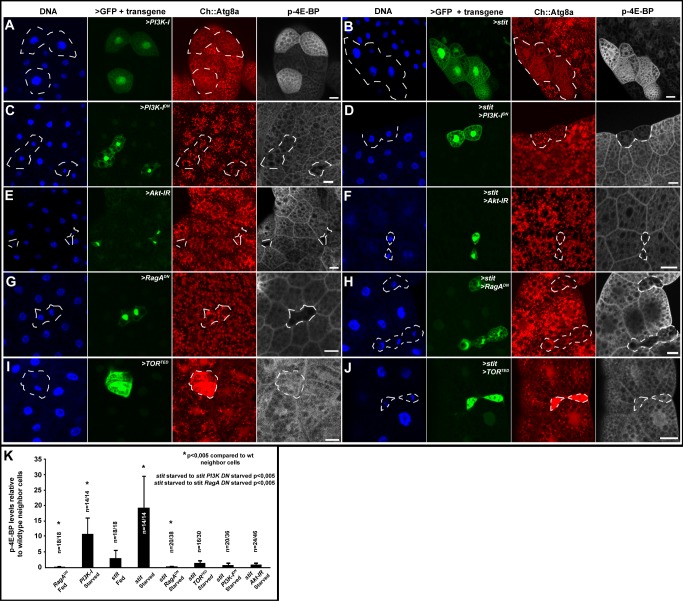
The PI3K-I/TORC1signalling cassette is required for Stit-dependent protection against starvation.Clonal expression (cells marked by GFP/hatched line) of stit and/or transgenes interfering with TORC1 signaling components in the fat body of starved (5 h) larvae expressing Ch::Atg8a under the control of a fat body promoter (A) PI3K-I-expressing cells have larger nuclei, are protected from starvation-induced Ch::Atg8a puncta formation, and maintain high p-4E-BP levels compared to wild-type neighbors. (B) stit-expressing cells behave like PI3K-I-expressing cells in (A). (C) PI3K-IDN-expressing cells are smaller and show Ch::Atg8a autophagic puncta and low levels of p-4E-BP (indistinguishable from neighbor cells). (D) stit and PI3K-IDN co-expression resulted in smaller cells with autophagic puncta and low levels of p-4E-BP following starvation, indicating PI3K-I signaling lies downstream of Stit. (E) Akt-IR, (G) RagADN, and (I) TORTED-expressing cells are smaller, readily form autophagic puncta, and had lower or similar p-4E-BP levels to neighbor cells. (F) Akt-IR, (H) RagADN, or (J) TORTED co-expression in cells expressing stit inhibited the increase in cell size, resistance to starvation-induced autophagy (Ch::Atg8a puncta), or maintenance of p-4E-BP levels, indicating that these members of the PI3K-I/TORC1 signaling cassette are required for Stit-dependent starvation resistance. Scale bars, 25 µm. (K) Plot of the ratios of p-4E-BP labeling intensities in cells expressing the transgene to wild-type neighbor cells. The number of overexpressing cells/wild-type nearest neighbor cells counted (n) is given. * indicates Student's t test p values <0.005 between transgene-expressing and wild-type neighbor cells. Co-expression of RagADN together with stit blocked stit-supported growth under starvation. This effect was so strong on p-4E-BP levels that it reduced levels far beyond the starved wild-type cell levels, giving significant differences. Inset p values compare differences in preservation of p-4E-BP signal between stit-expressing cells/wild-type neighbor cells and stit and transgene co-expressing cells/wild-type cells. Error bars indicate standard deviation.